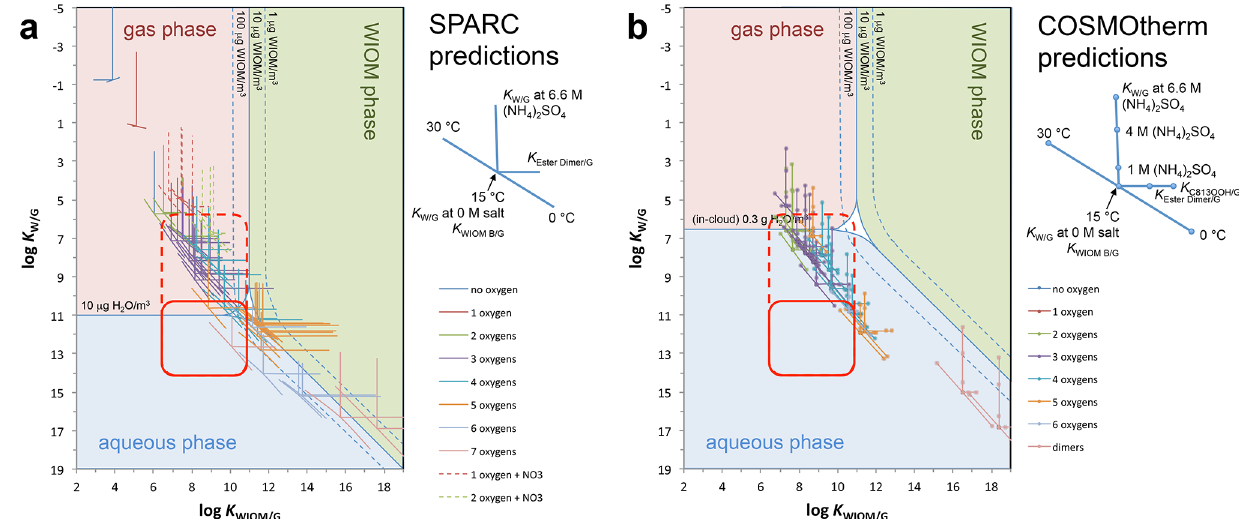
Figure 6. Placement of α -pinene and some of its oxidation products in the chemical partitioning space based on predictions with SPARC (a) and COSMOtherm (b) . Each chemical is represented by three lines, which account for the influence of temperature variations between 0 and 30 ◦ C (diagonal line), the salting-out effect by 6.6M (NH 4 ) 2 SO 4 (vertical line) and the polarity of the surrogate representing the solvation properties of WIOM (horizontal line). The chemicals are superimposed on the dominant phase distribution maps for wet aerosol (a) and a cloud (b) . The red lines encircle regions where chemicals fall whose contribution to SOA formation would not be considered if the aqueous phase in an aerosol (solid line) or cloud (dashed line) were